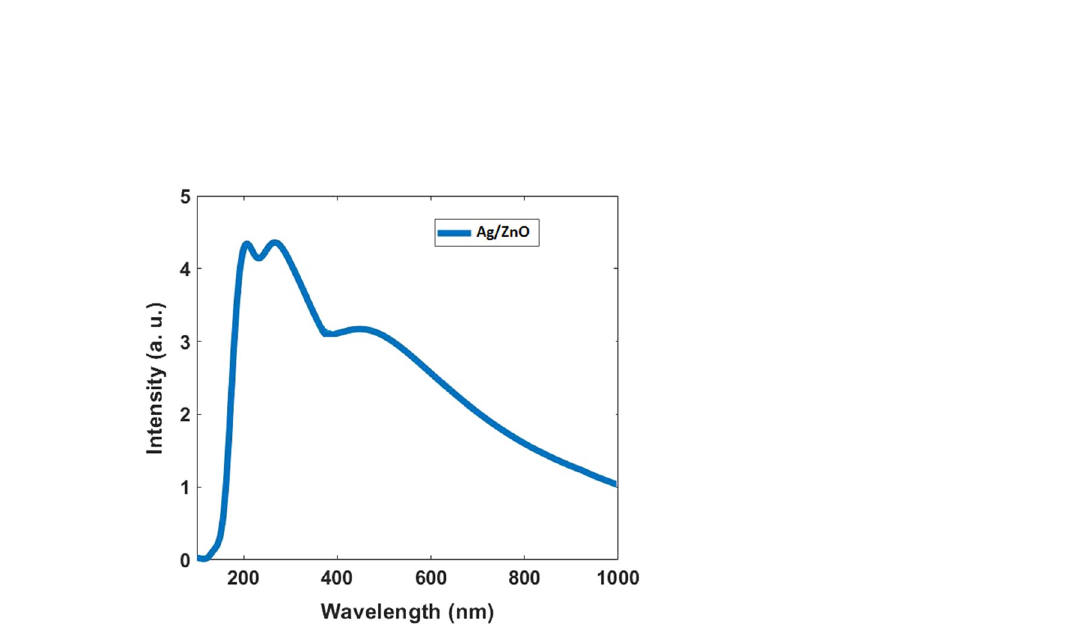
Figure 3. Absorption spectrum for synthesized Ag/ZnO